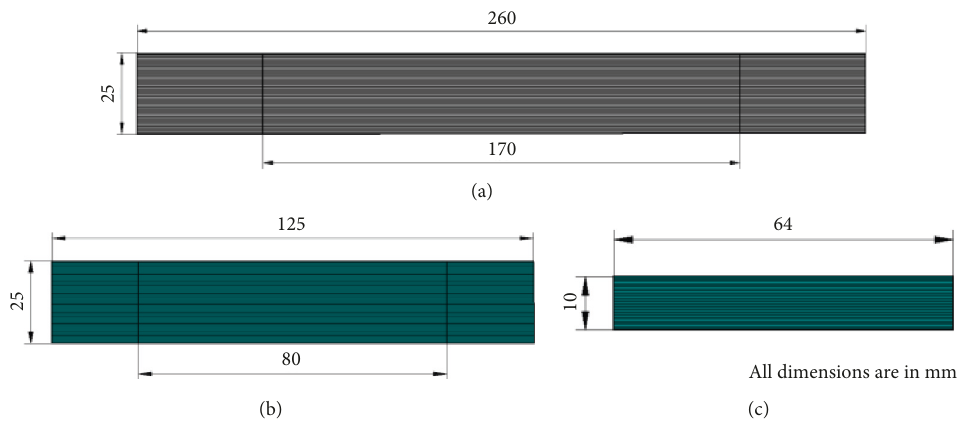
Figure 7: Specimen dimensions as per standards. (a) Tensile test specimen. (b) Flexural test specimen. (c) Impact test specimen.